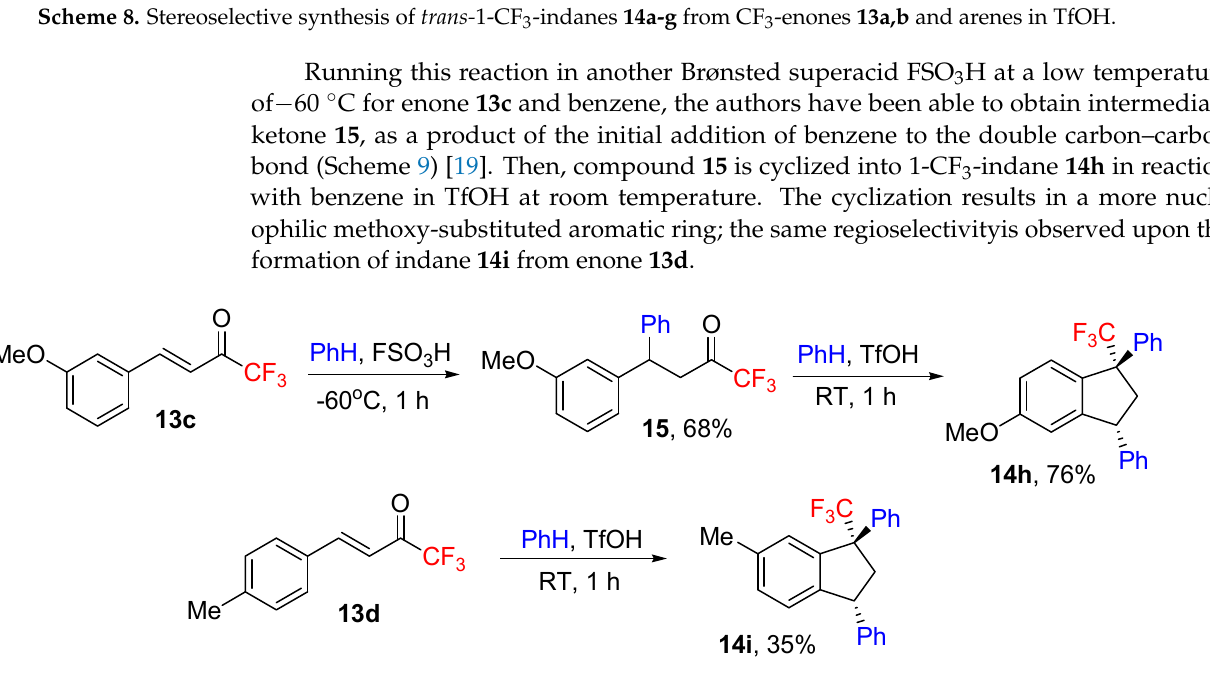
Scheme 8. Stereoselective synthesis of trans- 1-CF 3 -indanes 14a-g from CF 3 -enones 13a,b and arenes in TfOH.